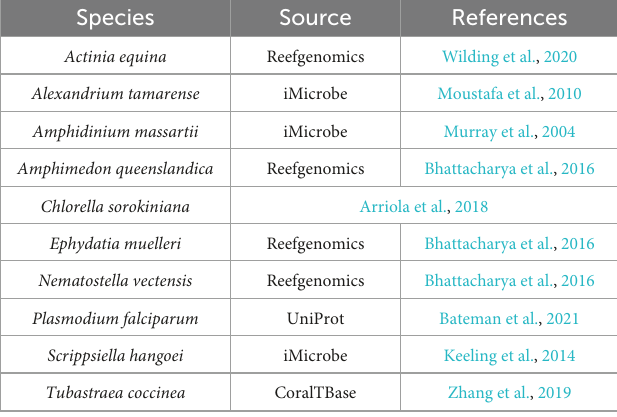
TABLE 4 The non-symbiotic species datasets used for